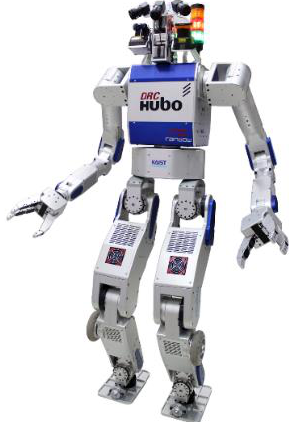
Figure 2. Humanoid Robot DRC-HUBO+.